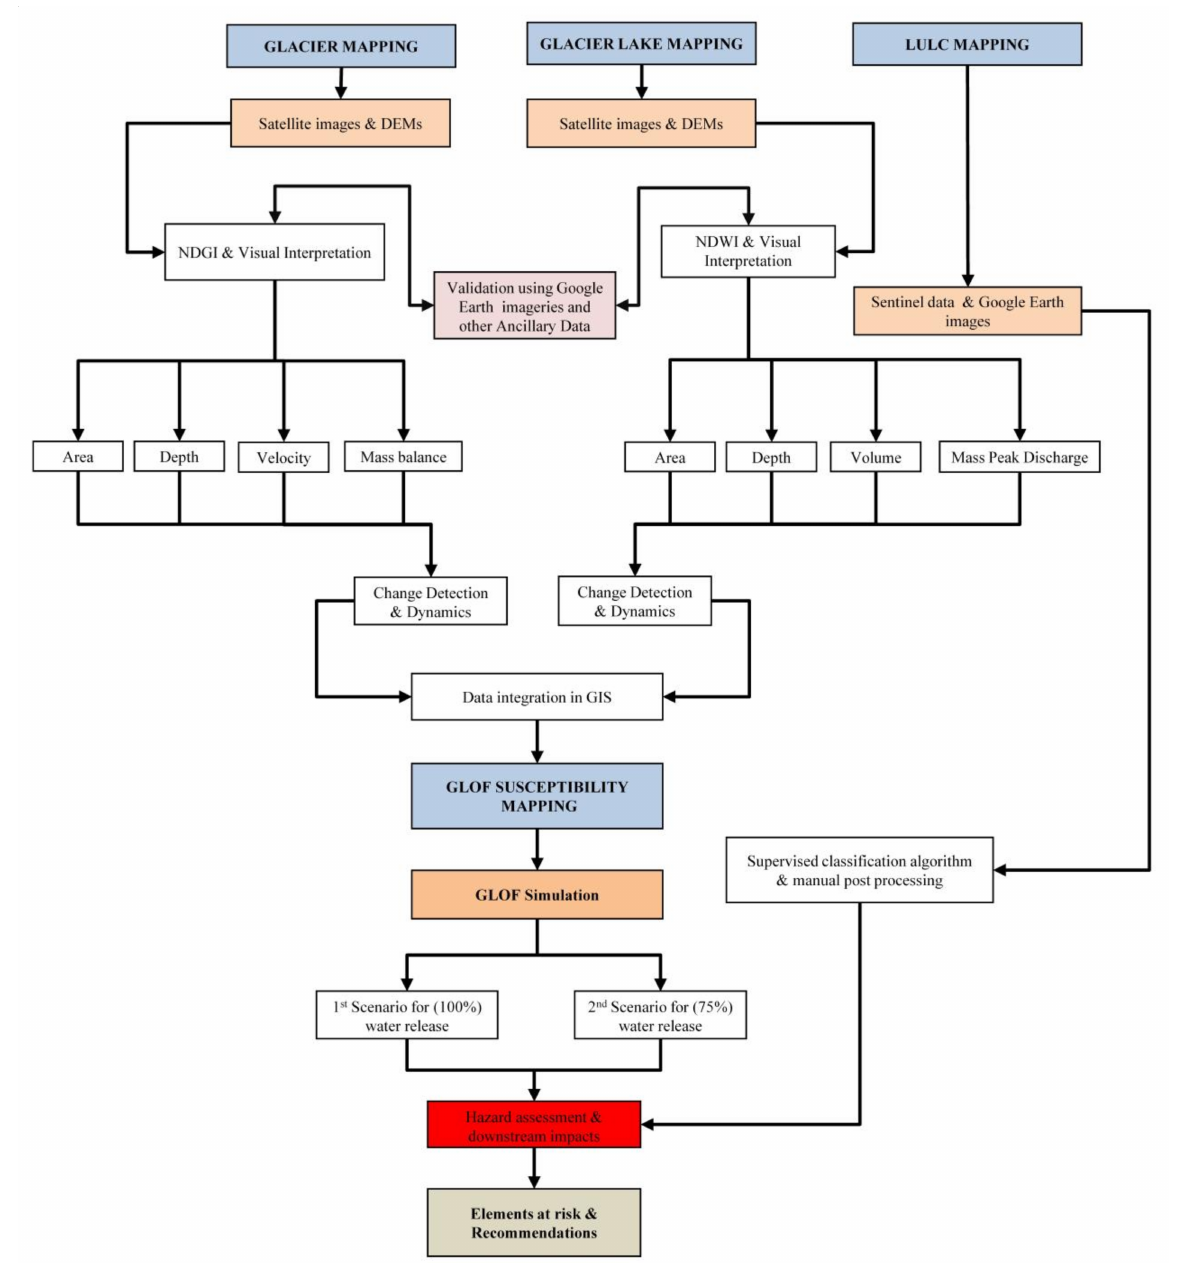
Figure 4. Overall methodology of this